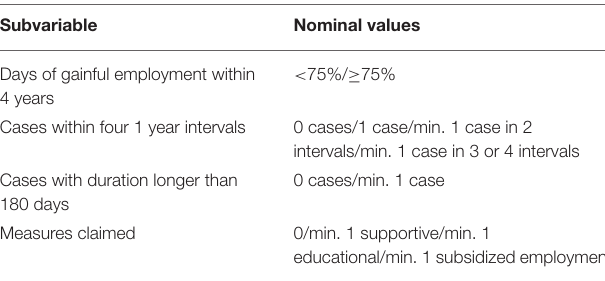
TABLE 2 | Variable characterizing prior occupational career through four